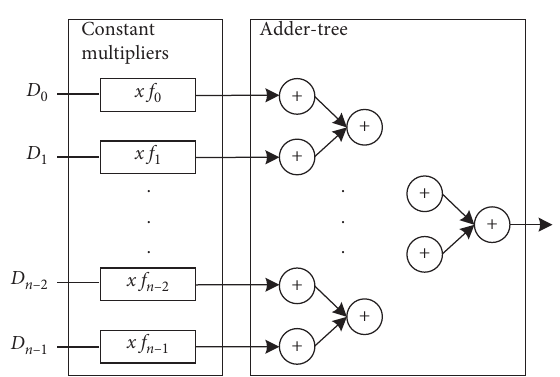
Figure 7: MAC module architecture.